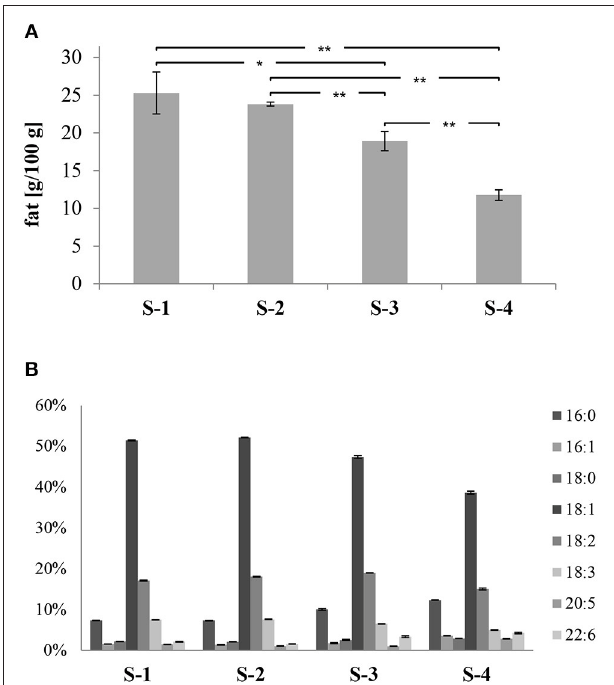
FIGURE 3 | (A) Total fat content of samples (g/100 g); (B) percentages of the individual fatty acids of samples, shown as relative amounts of total fat. The data are displayed as mean values of three independent replicates with their corresponding standard deviation and significance (** p < 0.01 and * p <